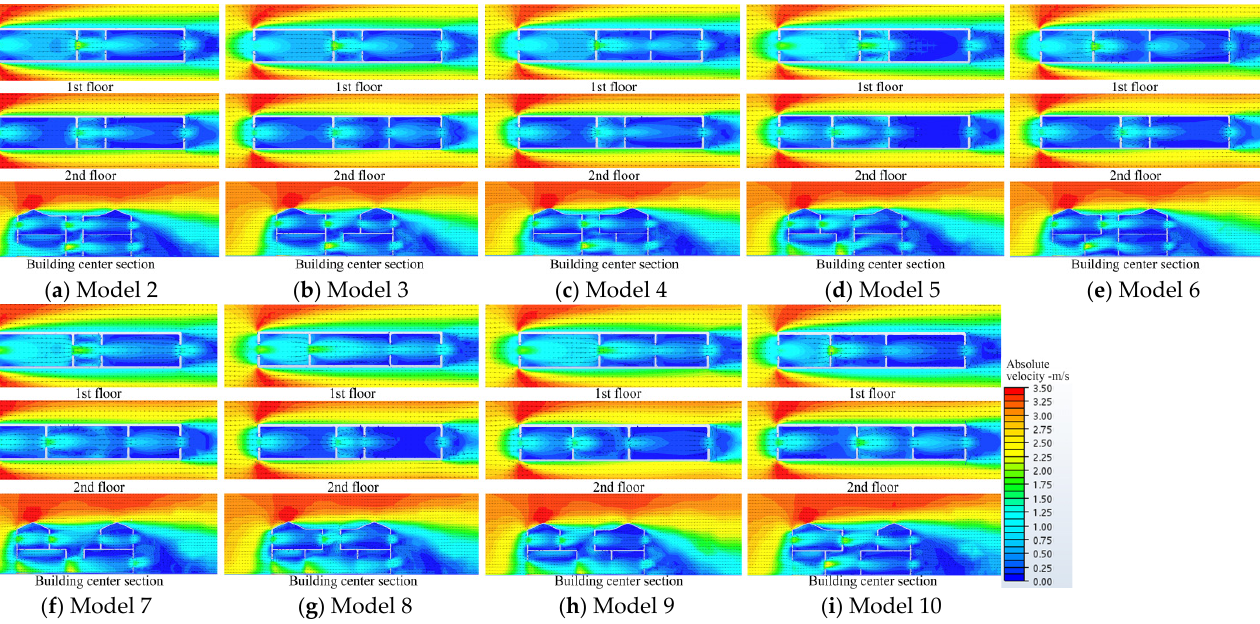
Figure 9. Simulated spatial distributions of V a in Models 2–10 at 12:00 at 1.2 m height on each floor. Judging from the change of profile shape, the courtyard space of Model 7 and Model 8 expanded and contracted from bottom to top, respectively. Figures 9 and 10 show that the cross ventilation changes little between the two types compared to air temperature changes. In particular, the average V a of courtyard on the second floor of Model 8, only decreases by 0.12 m/s, but the T a drops by approximately 3.0 °C. Consequently, the APMV value reduces as the courtyard adopts a contracted shape. In the front room on the first floor of Model 8, the APMV has dropped below 1, which is the only one evaluated as level Ⅱ ( − 1 ≤ APMV < − 0.5, or 0.5 < APMV ≤ 1 ) in the assessment level of the non-artificial thermal environment of all rooms.